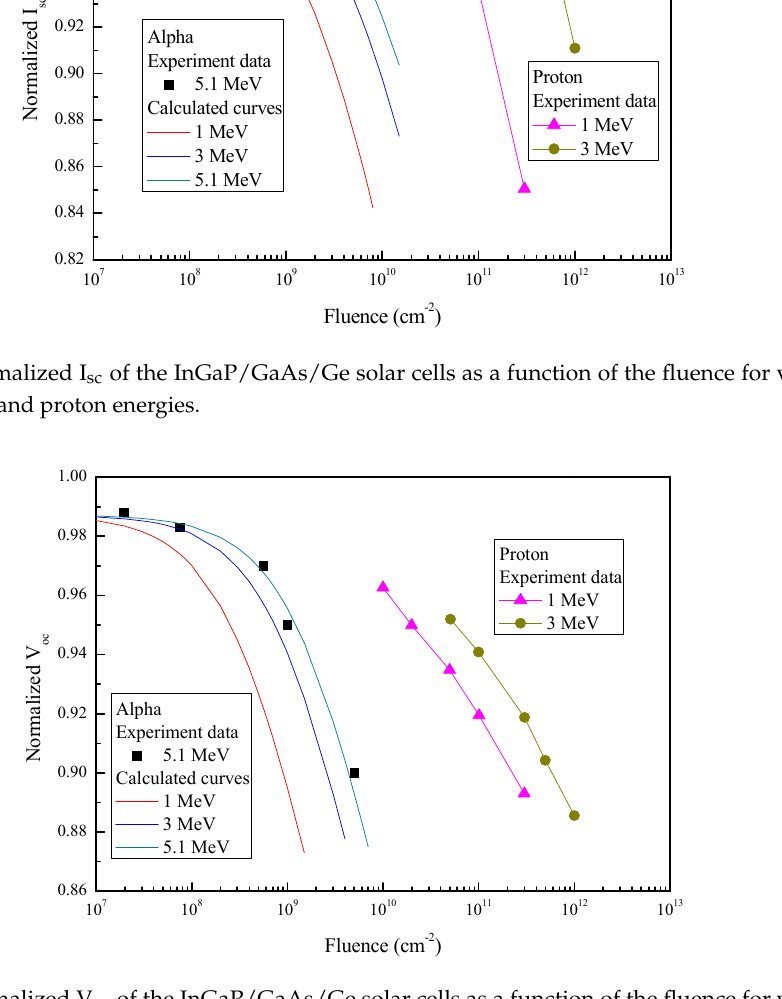
Figure 7. Normalized V oc of the InGaP/GaAs/Ge solar cells as a function of the fluence for various alpha-particle and proton energies.